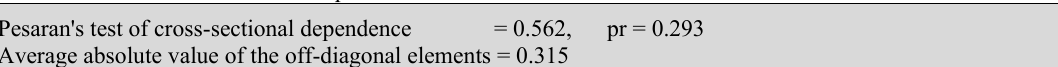
Pasaran CD test of cross-sectional dependence Pesaran's test of cross-sectional dependence = 0.562, pr =